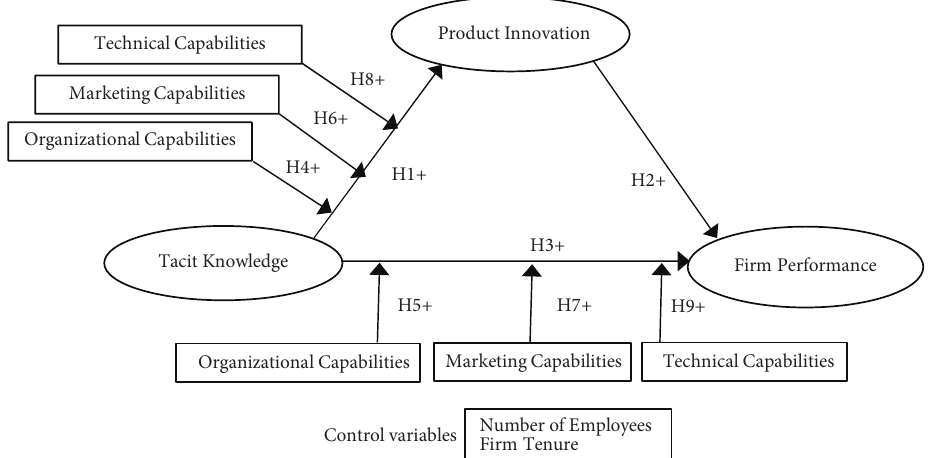
Figure 1. Proposed